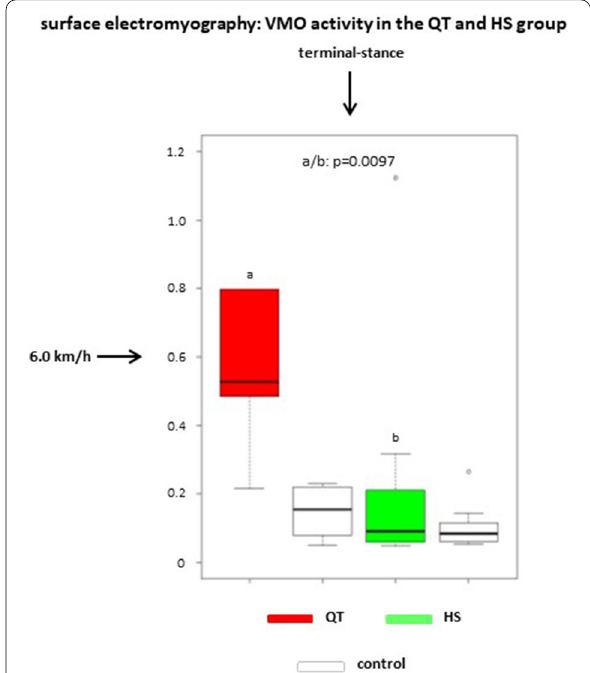
Fig. 4 Boxplot chart showing VMO activity (µV) for the treated and contralateral side in the QT and HS groups during terminal stance at 6.0 km/h. There is a significant difference between the QT and HS groups regarding the treated